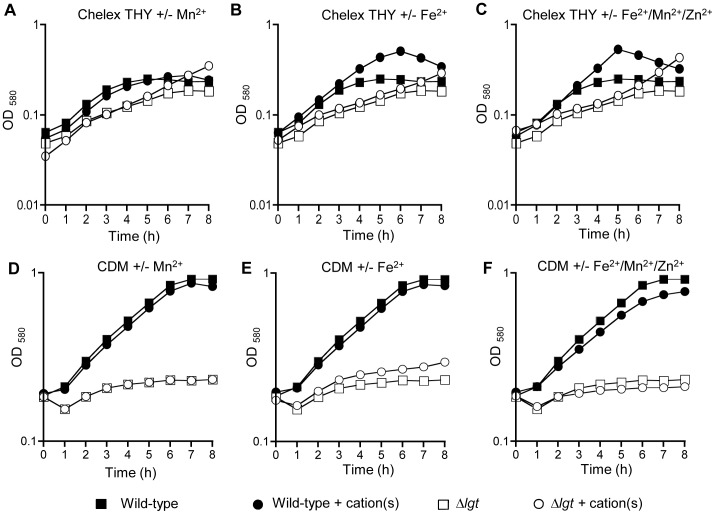
Growth of the wild-type and Δlgt strains in cation depleted media.Assessed by measuring broth culture log10 OD580 over time. (A) to (C) Growth in cation depleted chelex-THY and (D) to (E) in CDM with and without cation supplementation: (A) and (D) with and without Mn2+ supplementation; (C) and (E) with and without Fe2+ supplementation; and (D) and (F) with and without combined Mn2+, Fe2+ and Zn2+ supplementation. Filled symbols represent growth of the wild-type strain, empty symbols growth of the Δlgt strain. Squares represent growth in unsupplemented media, inverted triangles in media supplemented with 50 µM Mn2+, diamonds in media supplemented with 50 µM Fe+2 and circles in media supplemented with 50 µM Mn+2, Fe+2 and Zn+2.